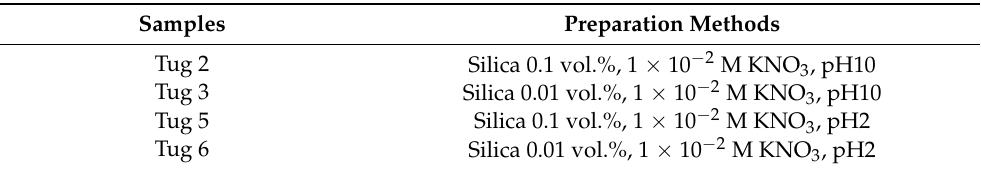
Table 2. List of the silica nanoparticle suspensions studied.